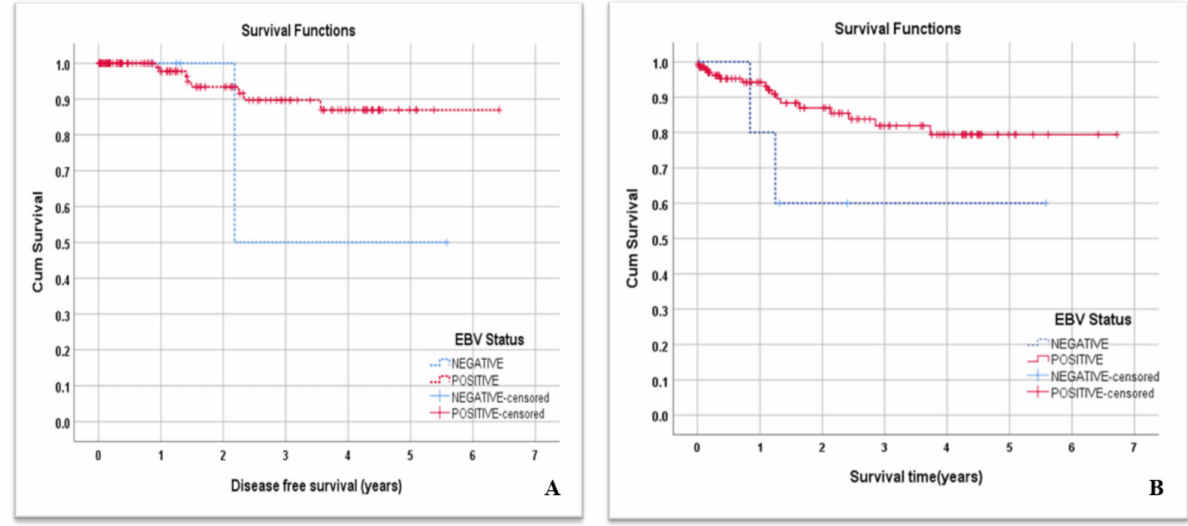
Figure 2. ( A ) Disease-free survival; ( B ) overall survival curves of all patients by EBV status.